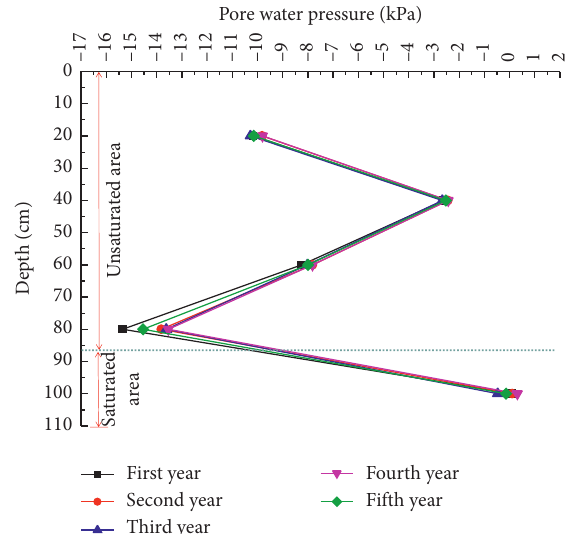
Figure 12: Pore water pressure variations with depth at the end of the five years.